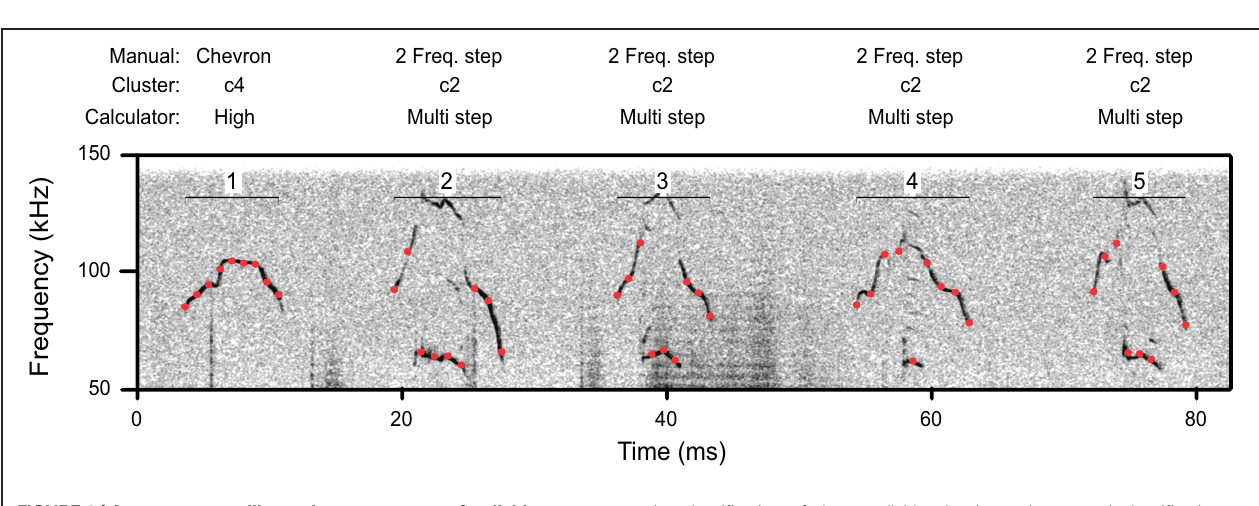
FIGURE 2 | A spectrogram illustrating a segment of syllables from a p11 CBA/CaJ pup. Red dots indicate the location of automatic measurements of the nine-point frequency contour. Above ,